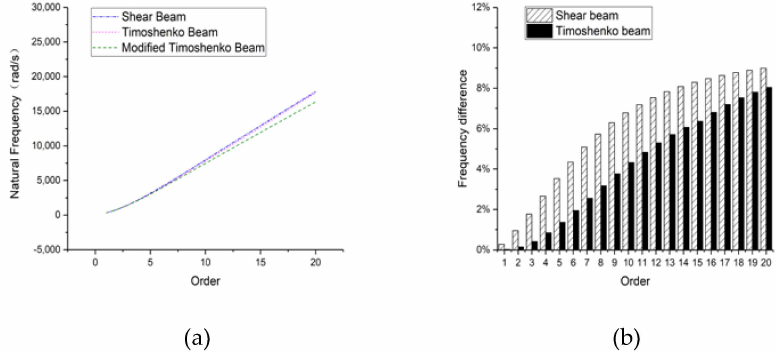
di ff erence compared with a modified Timoshenko beam.